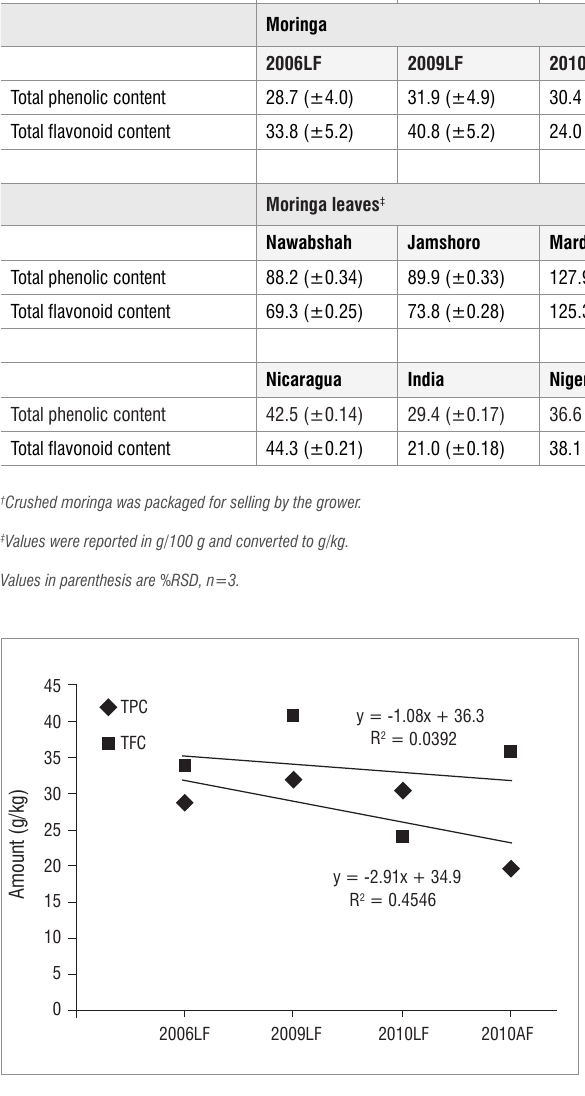
Figure 1: Correlation between total phenolic content (TPC) or total flavonoid content (TFC) and age of the moringa plant.